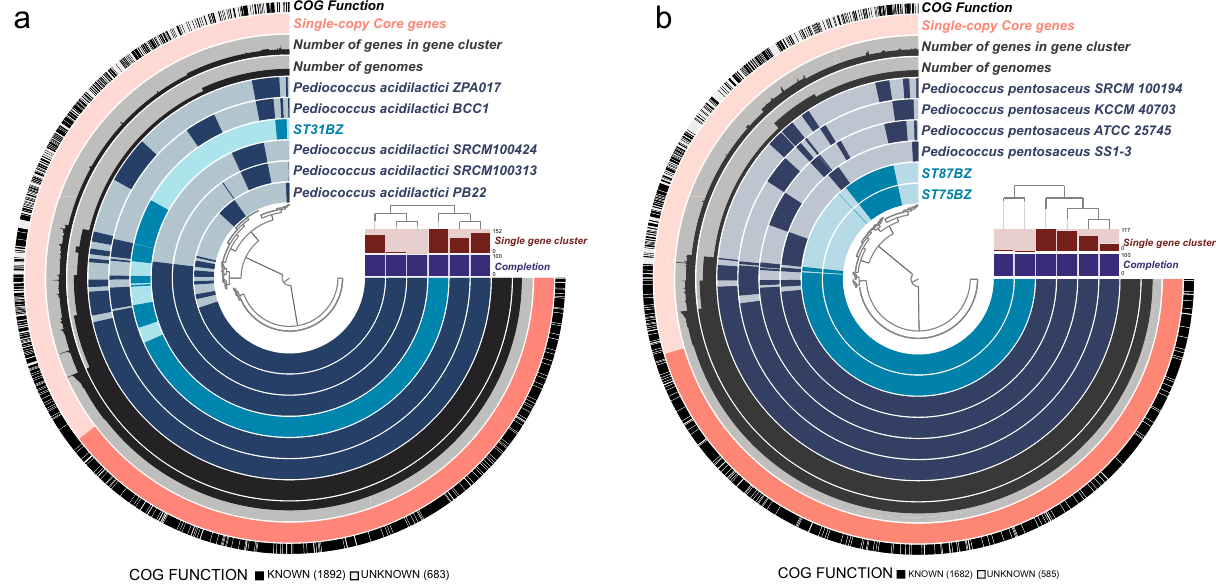
Figure 3. Pangenomic comparison. ( a ) Isolate of Pediococcus acidilactici ST31BZ, ( b ) Pediococcus pentosaceus ST75BZ and Pediococcus pentosaceus ST87BZ using Anvi’o. ST31BZ was compared with five complete genomes of Pediococcus acidilactici (strains ZPA017, BCC1, PB22, SRCM100424, and SRCM100313). ST75BZ and ST87BZ were compared with four complete genomes of Pediococcus pentosaceus (strains SS1-3, ATCC